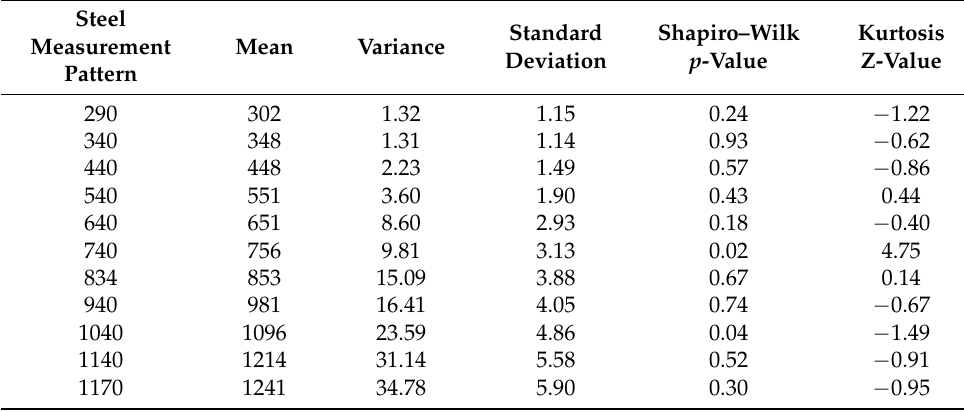
Table 7. Statistical analysis of VL53L1X for tests with no excessive ambient light.